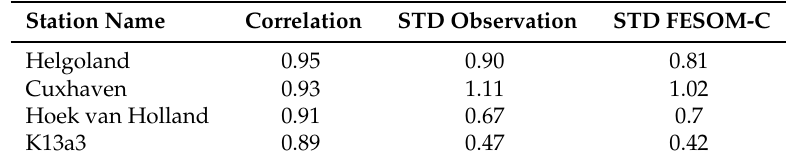
Table 2. Correlation between observed and simulated sea surface height (ssh) at four stations. Standard deviation (STD) in time arrays of observed and modeled values of ssh.